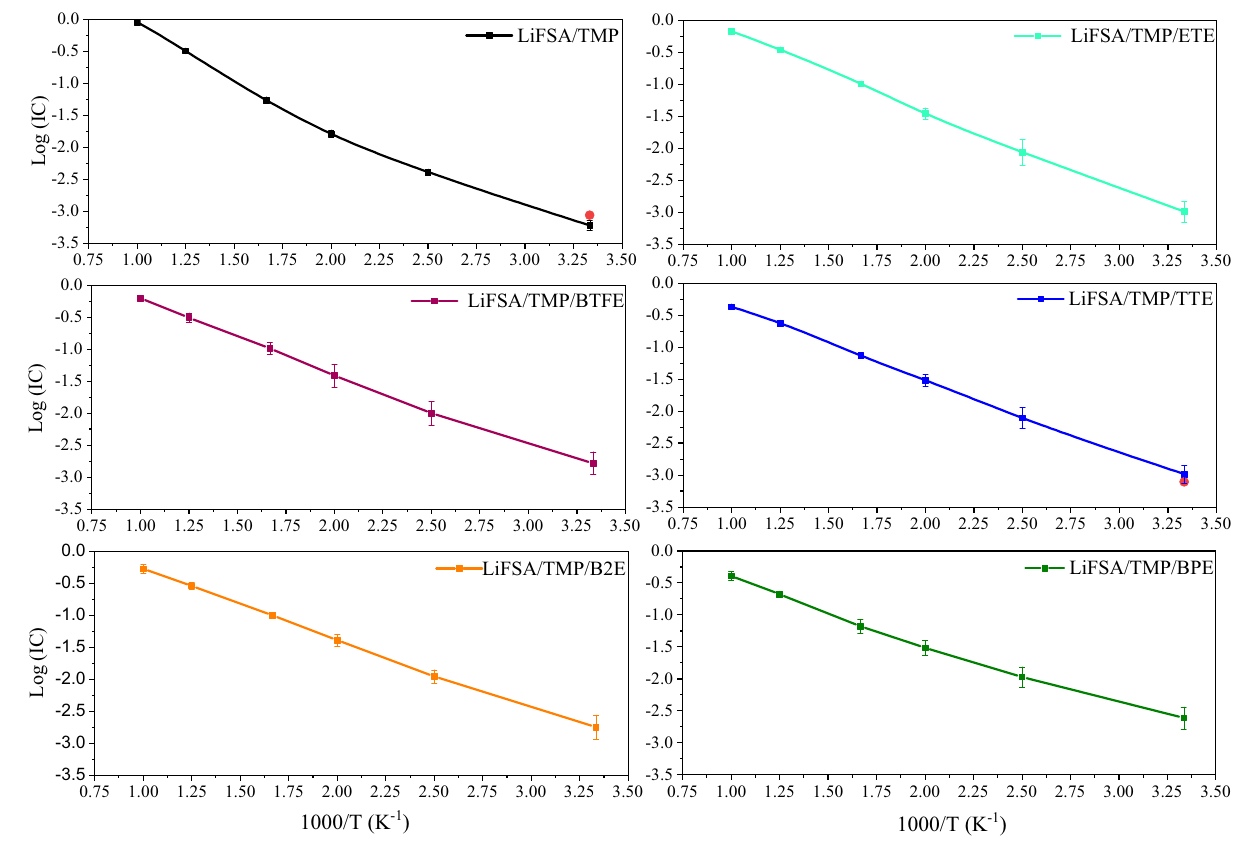
Figure 3. The calculated ionic conductivities as a function of temperatures for ( a ) HC and the diluted LiFSA/ TMP based electrolyte by ( b ) ETE, ( c ) BTFE, ( d ) TTE, ( e ) B2E and ( f ) BPE, respectively. The red point presents the experimental value 10 .